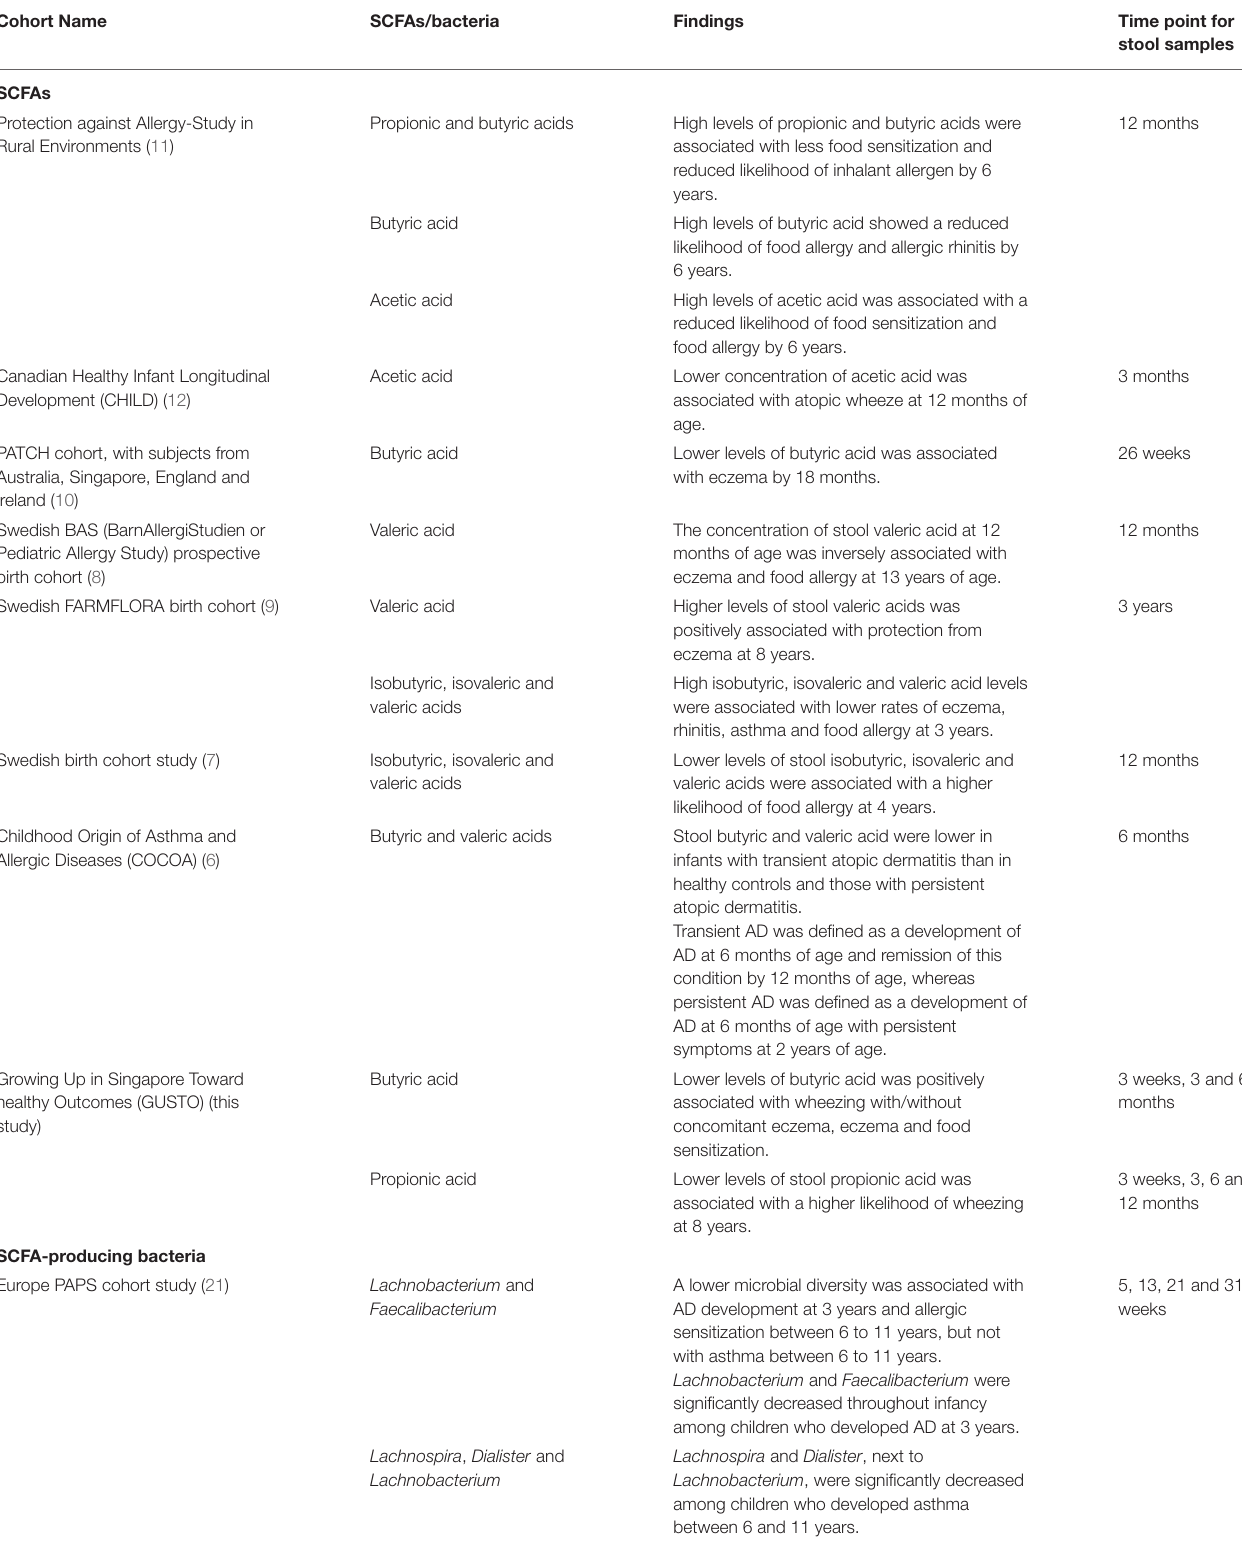
TABLE 1 | Summary of the current cohort studies on the relation between stool SCFA levels and allergy-related